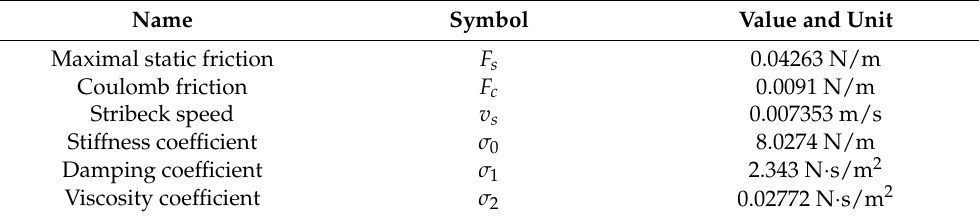
Table 2. Relevant parameters of friction